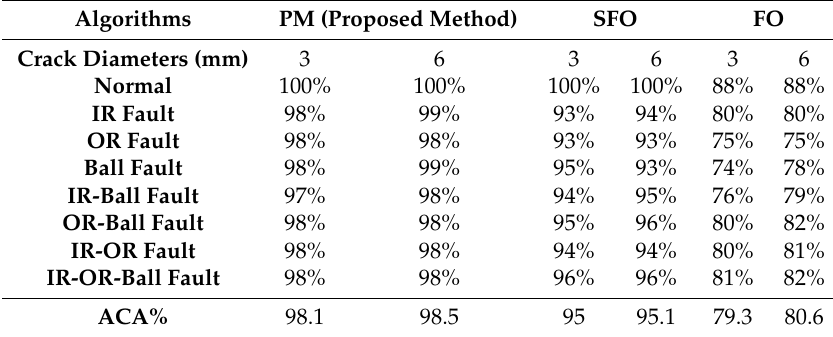
Table 9. The multi-fault diagnosis accuracy for 400 RPM torque speed.